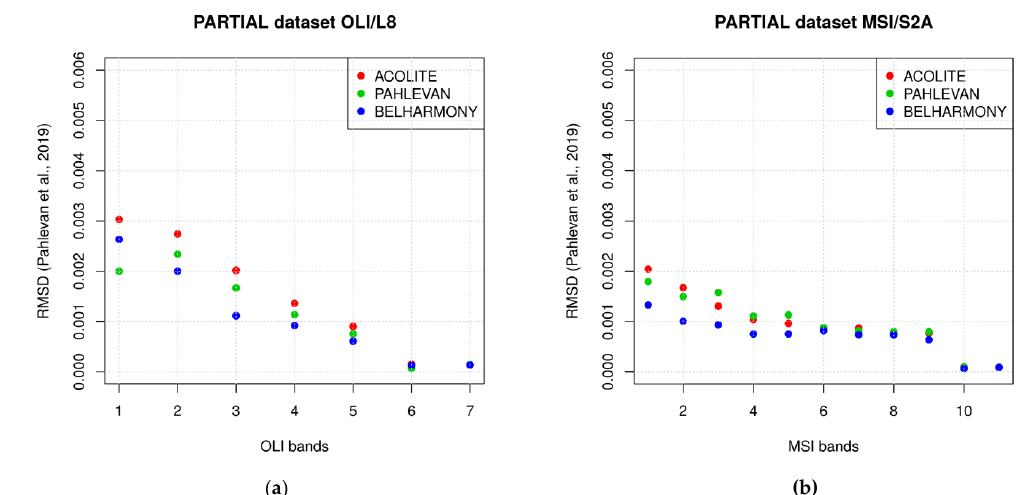
Figure 9. Root mean square deviation (RMSD) of Rrs provided by AERONET-OC and obtained by ACOLITE with Pahlevan and Belharmony gains and without gains for ( a ) OLI/L8 and ( b ) MSI/S2A not included in the Belharmony calculation.